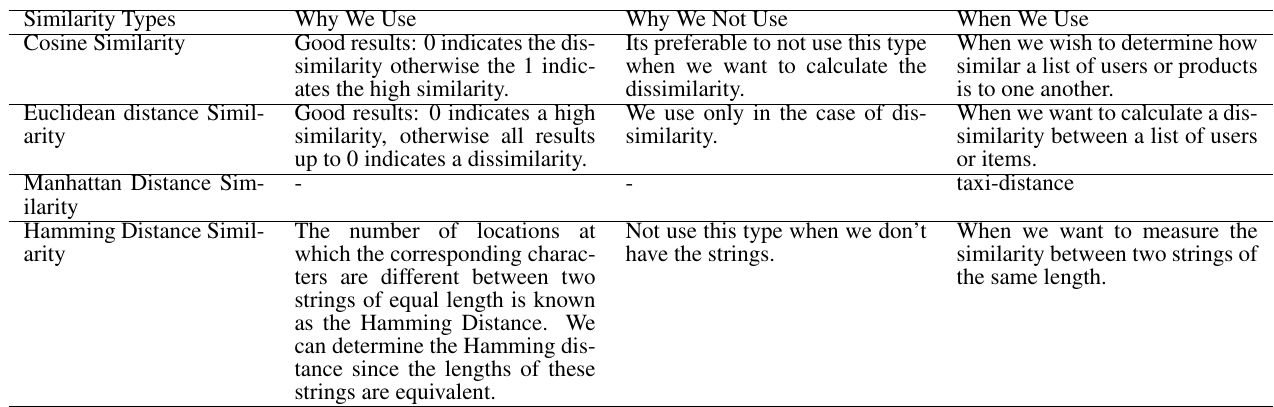
Figure 3. Similarity Metrics for Scenario Case 1. Table 1. Most important metrics used in collaborative filtering.